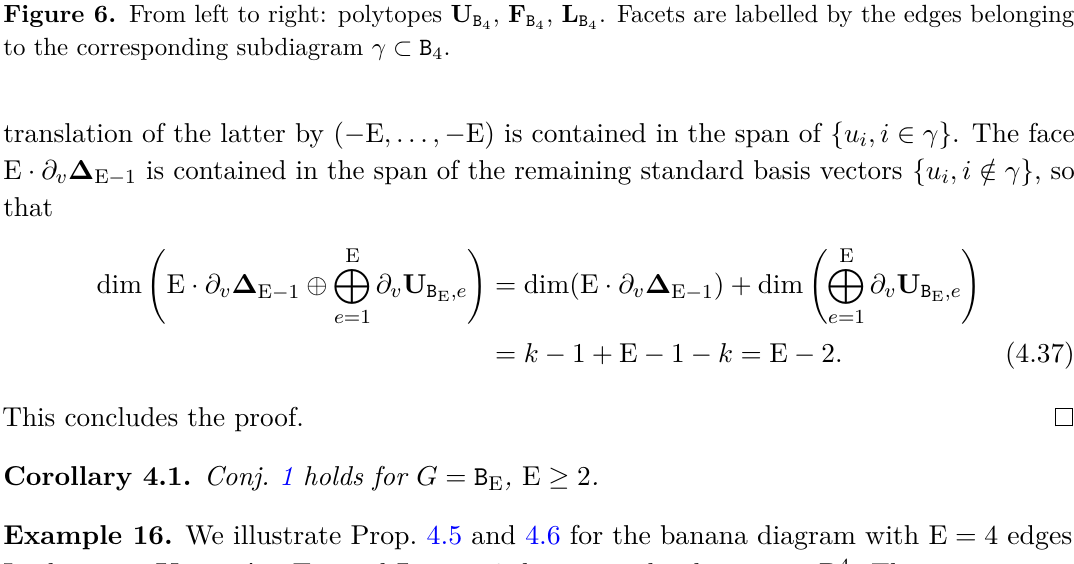
, F , L . Facets are labelled by the edges belonging B 4 B 4 B 4